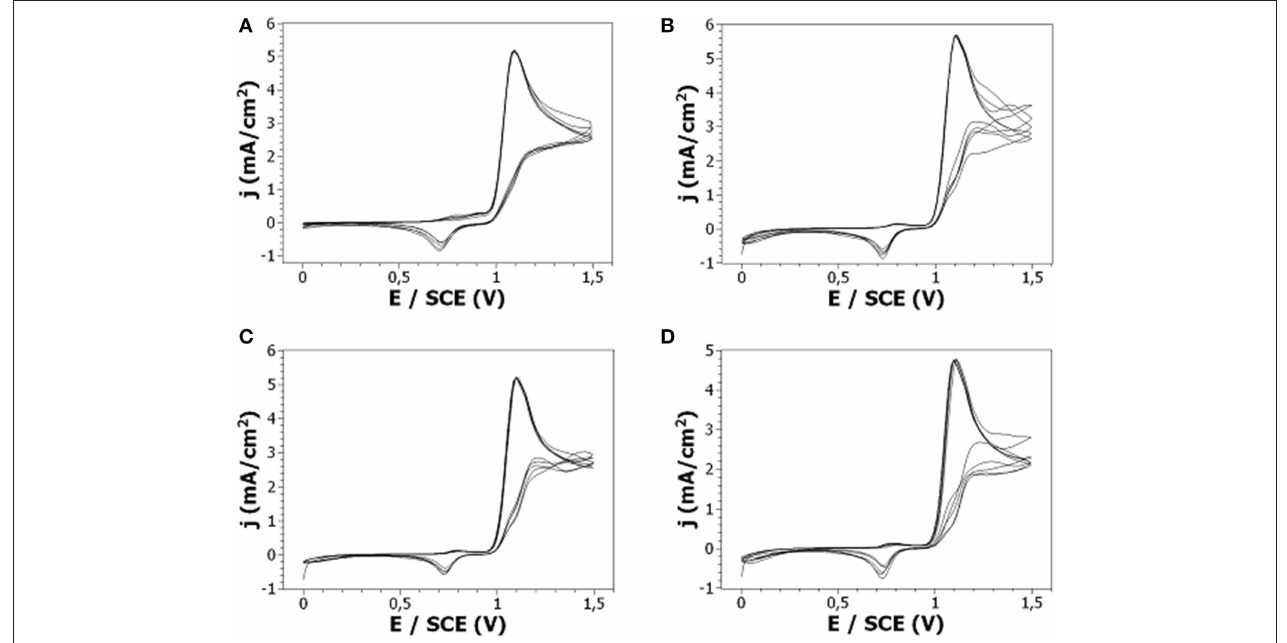
FIGURE 6 | Cyclic voltammetry at a Pt electrode of 10 − 2 M: (A) Cz1Me, (B) Cz3Me, (C) Cz5Me, (D) Cz7Me + 0.1M LiClO 4 in ACN. Scan rate: 50 mV/s.